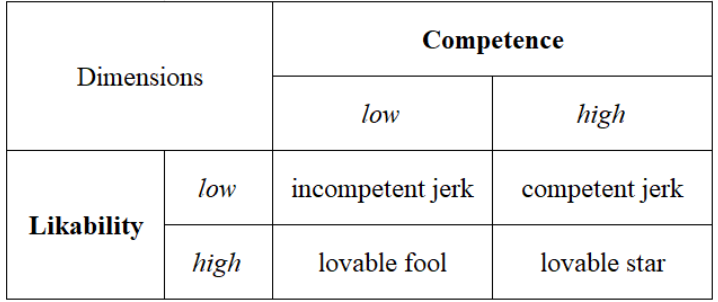
Figure 1. Likability – Competence Model